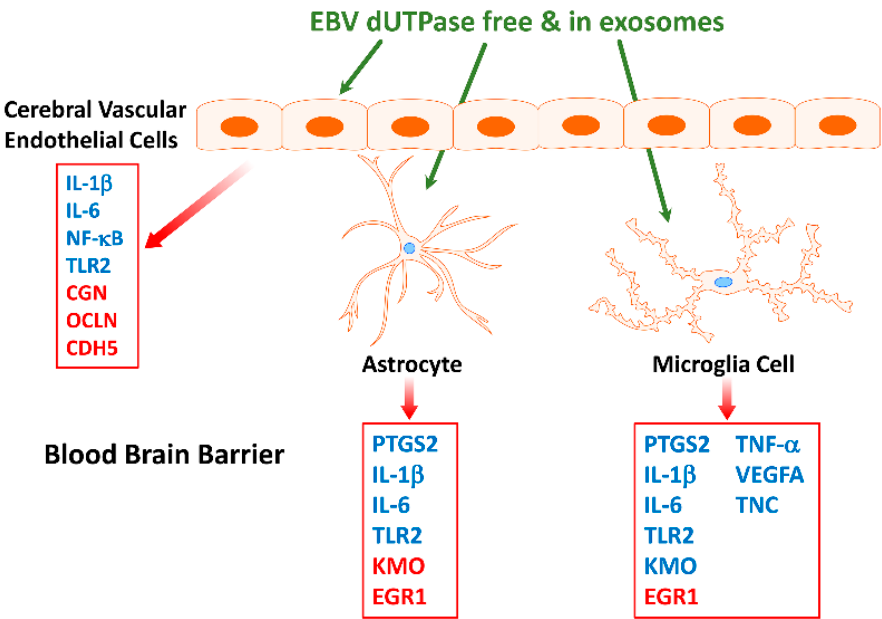
Figure 4. Diagram demonstrating the effect of EBV dUTPase on gene expression in immortalized primary human cerebral microvascular endothelial cells, astrocytes and microglia cells. Genes in blue were significantly upregulated while those in red were significantly downregulated when compared to controls [120].